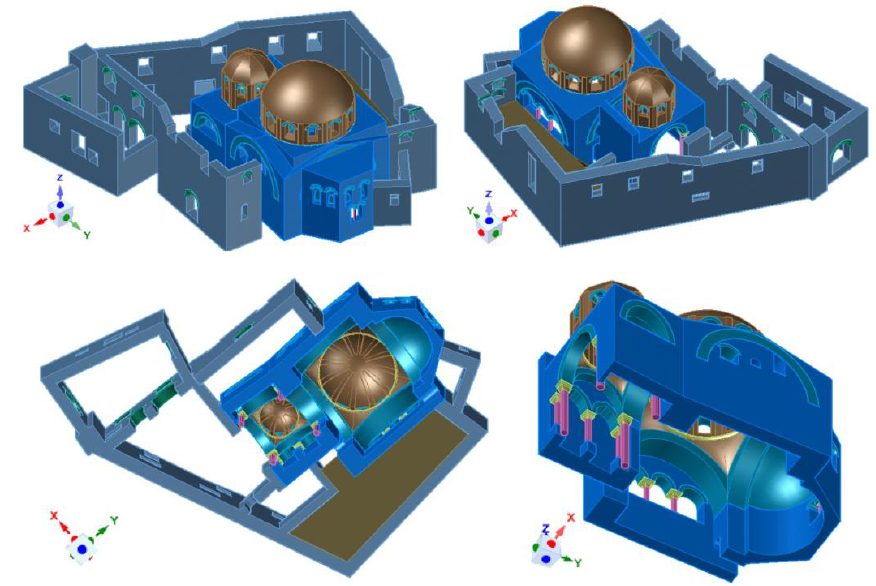
Figure 11. Three-dimensional solid model of the structure in AutoCAD.